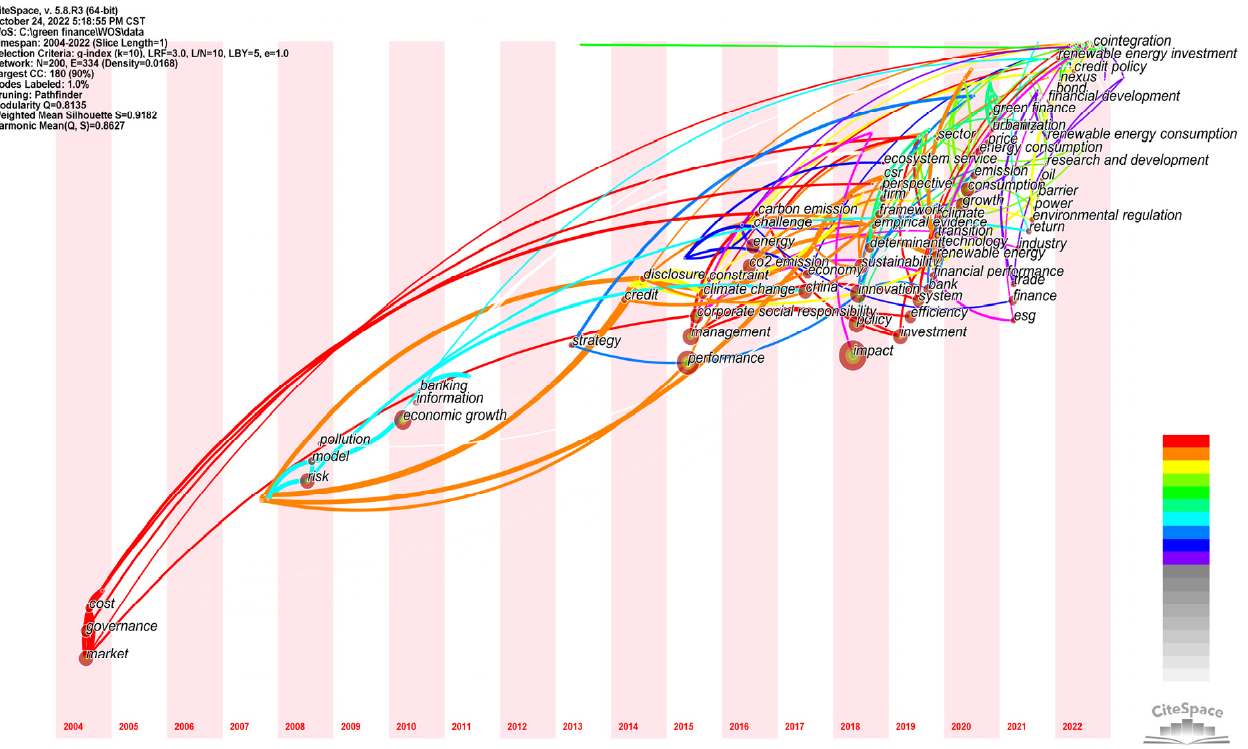
Figure 15. WOS time zone diagram.